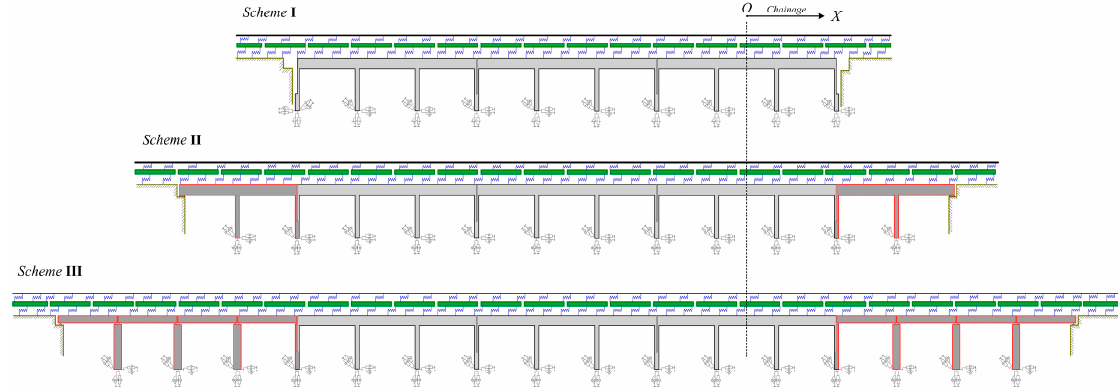
Figure 17. Three calculation models of the adjacent bridges with different arrangement schemes.